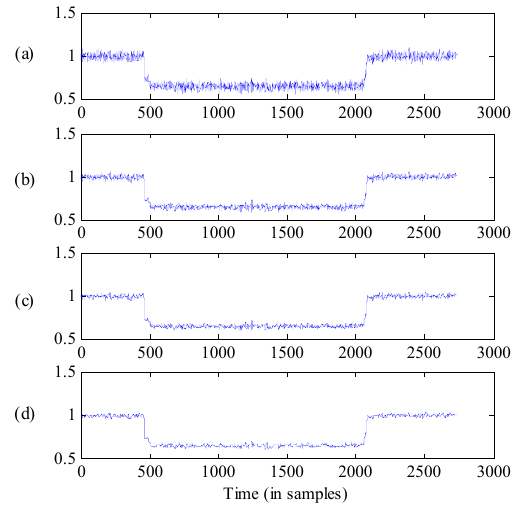
Figure 10. The denoising result from MRSVD: ( a ) Magnitude waveform; ( b – d ) Approximation component at the first, third, and fifth decomposition level.